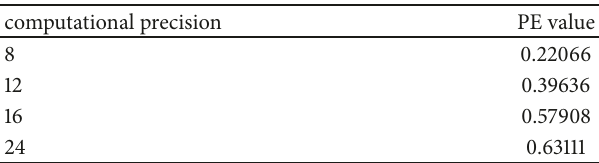
Table 1: The PE value of discrete Logistic sequences with different computational